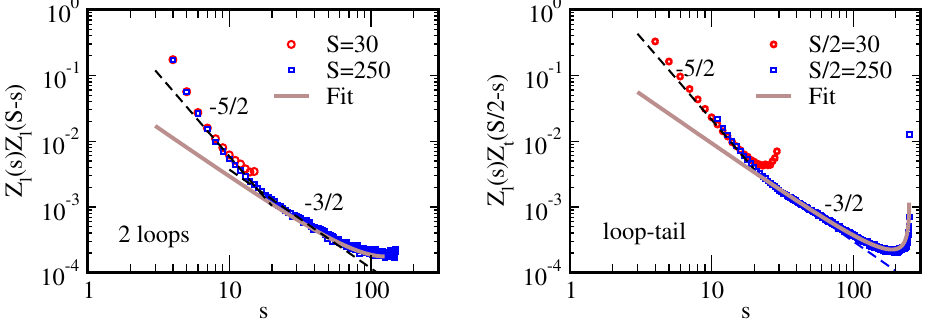
Figure 5. Loop distribution as simulated by molecular dynamics for two chain lengths ( S = 30 b and S = 250 b). The persistence length is (cid:96) = 10.1 b throughout. (left) Distribution of the internal loop size upon first adsorption of a loop of size S ; only the smallest of the generated internal loops is taken into account; the full distribution is symmetric about S /2. We show the power law fit by the single loop partition function (dashed lines) for the stiff loop and for the flexible loop, which apply where they should. Note the rather narrow crossover around s = 2 (cid:96) . The product of loop flexible partition functions nicely accounts for the flattening near s = S /2 required by symmetry. (right) Distribution of the size of the loop generated by first re-adsorption of a tail of length S /2. Again, the single loop partition functions fit where they should; the narrow crossover is now located around s = (cid:96) . The product of the flexible loop and tail partition functions accounts for the upturn near s = 125 b where the small tail partition function